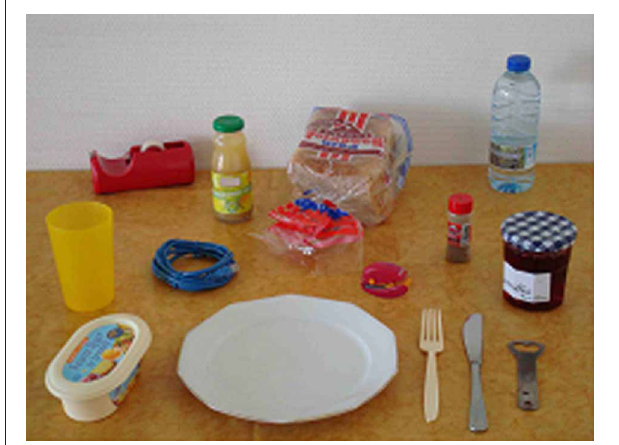
FIGURE 1 | Example of scene layout used in this experiment. The scene contained both 7 task-relevant (bread, butter, jelly, knife, plate, glass, water bottle) and 7 irrelevant